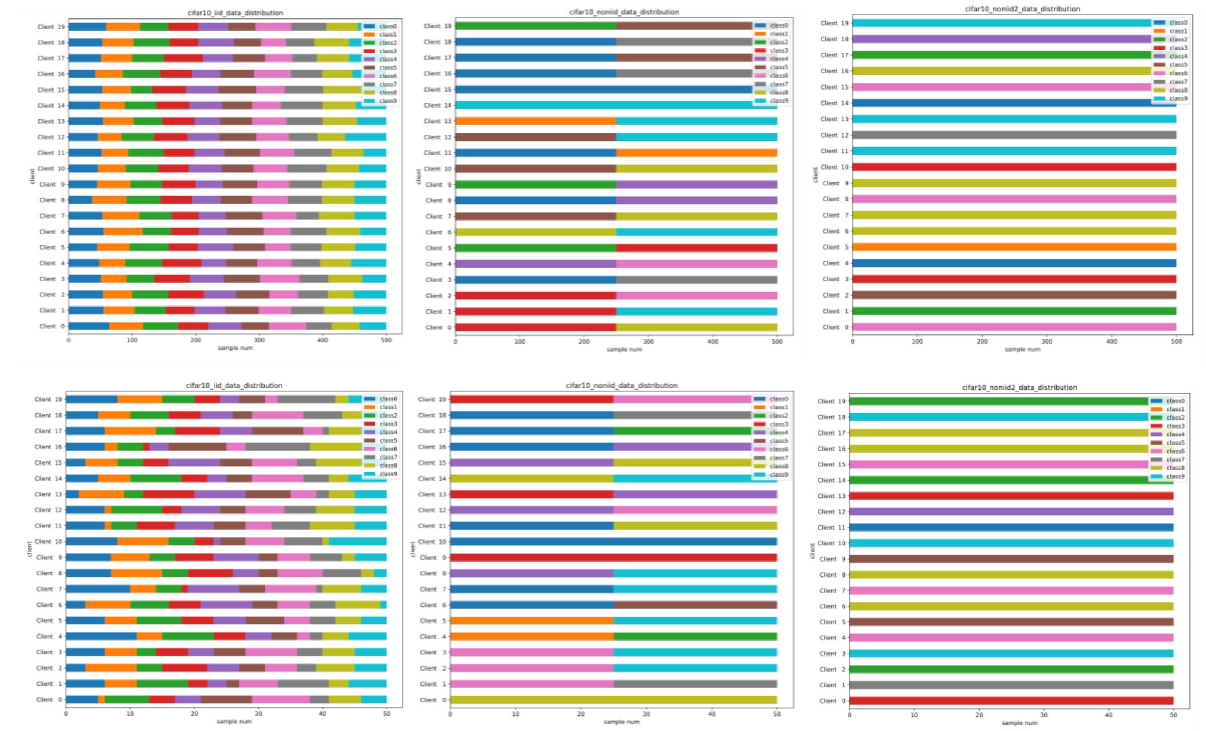
Fig. 8 Data distribution of the top 20 clients in the Cifar-10 dataset (moderate device number is above, massive device number is